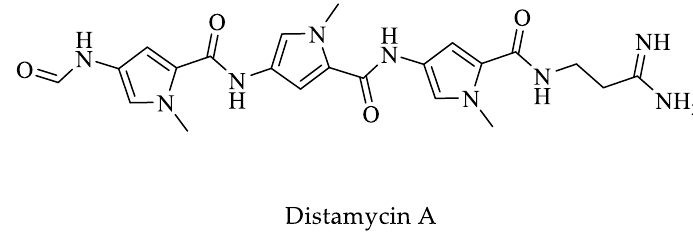
Figure 14. Structure of compound that affects Eh MLBP.